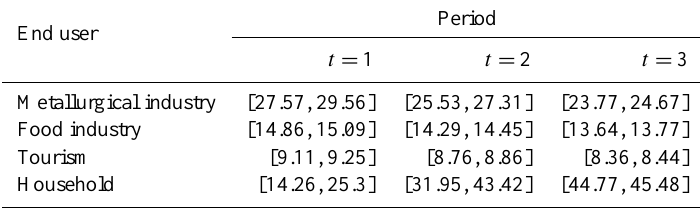
Table 1. Benefits of water supply for end users (USDm − 3 ).